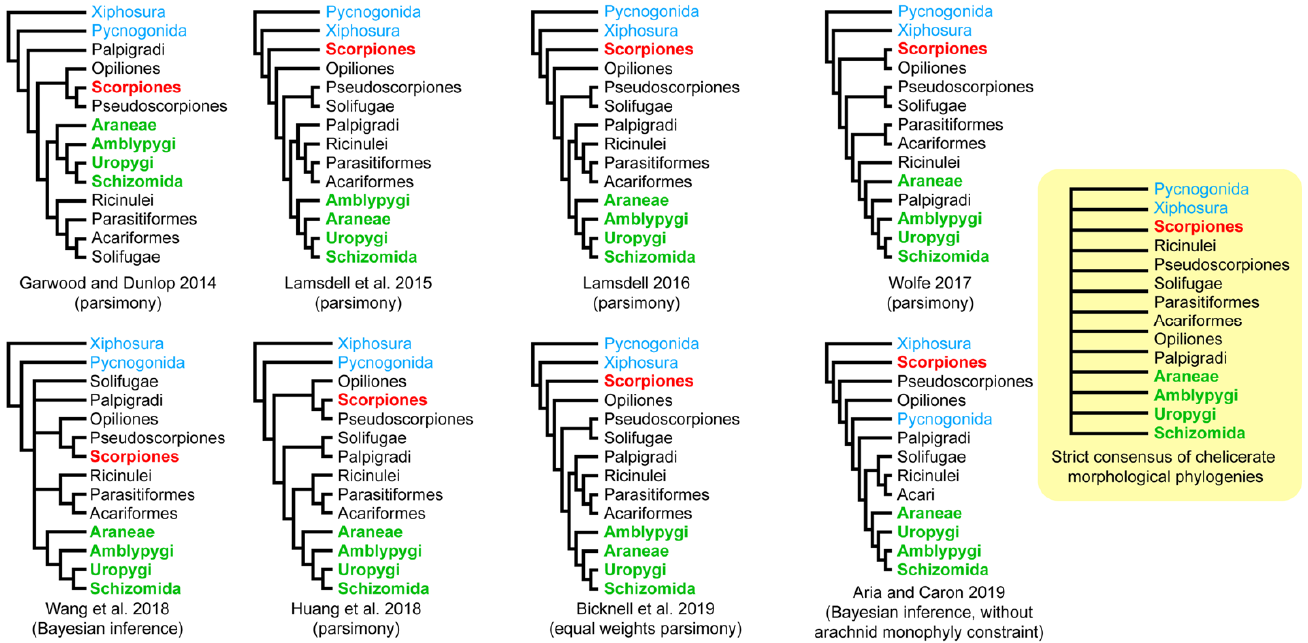
Figure 1. Phylogenetic relationships of chelicerate orders based on recent analyses of morphological datasets. Fossil taxa have been removed for clarity. Blue: marine orders; green: Tetrapulmonata; red: Scorpiones.